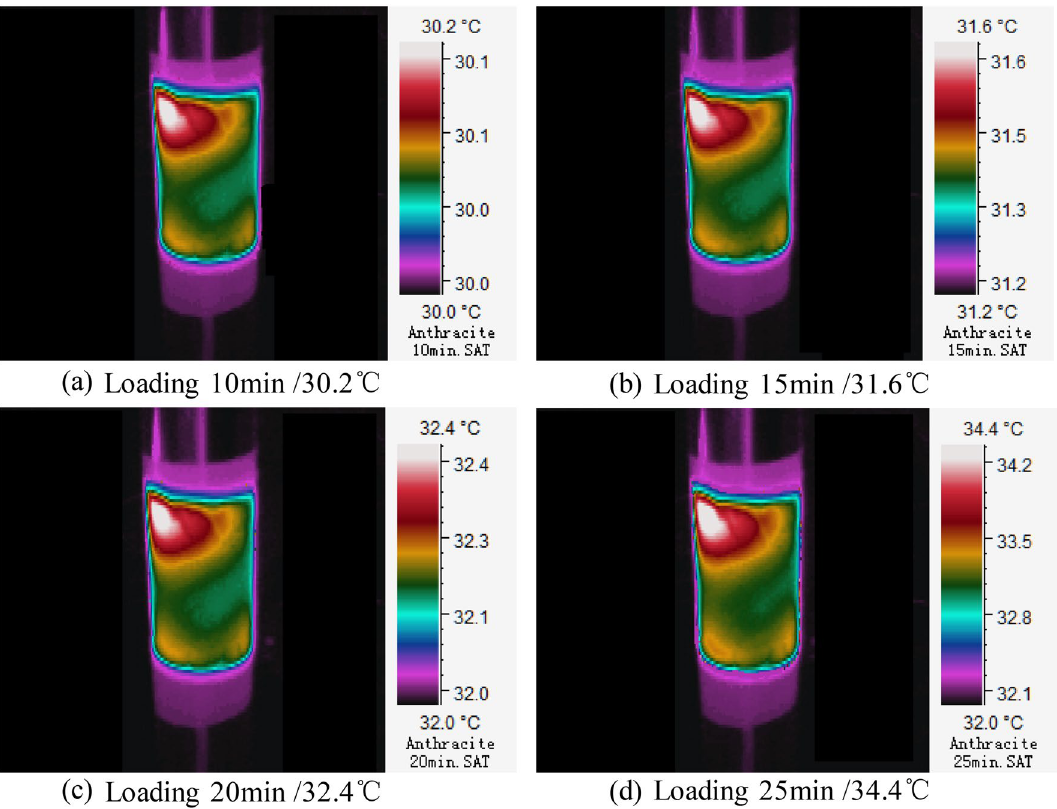
Figure 5. Three-dimensional infrared cloud maps of slowly warming stage.